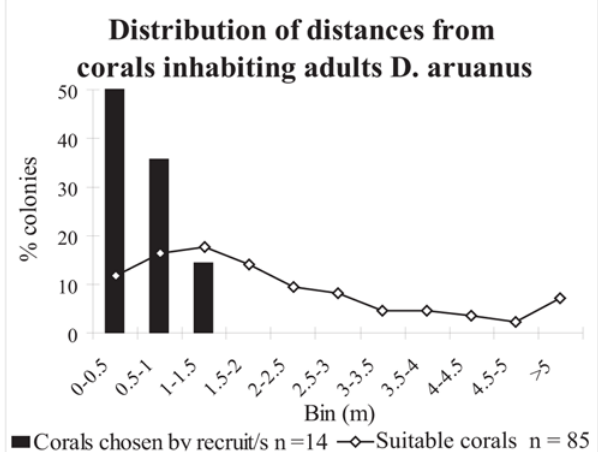
Figure 1. The distribution of distances of tagged corals in part of the transect from corals hosting D.aruanus adults. Columns: corals that were chosen by D. aruanus settlers. Line: all suitable corals (species and size that D. aruanus settlers usually